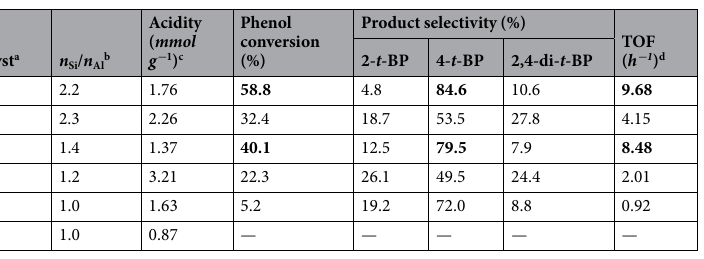
— — — — — Table 3. Catalytic activities of various zeolites. a Reaction conditions: T = 160 °C; t -BA/Phenol = 2; WHSV = 7 h –1 ; TOS = 24 h ; b Determined by 29 Si MAS-NMR; c Determined by NH 3 -TPD; d n phenol /( n Al . t (reaction